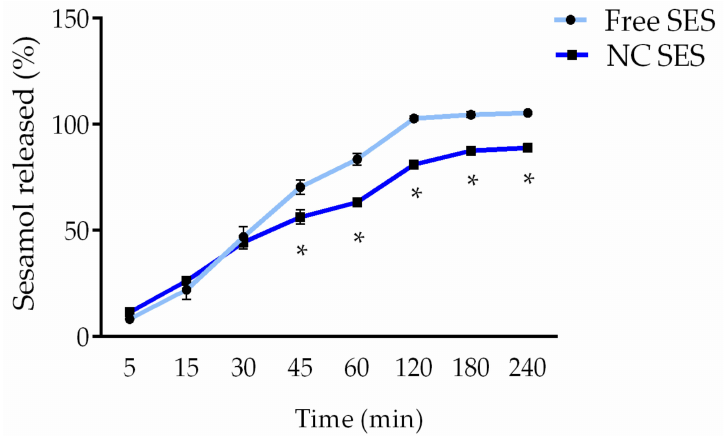
Figure 2. In vitro release profile of sesamol in the free (Free SES: light-blue line) or nanoencapsulated forms (NC SES: blue line). The values are reported as the mean ± SD of three independent experi- ments/group. All data were analyzed using the unpaired Student’s t -test at each point (individual time). The asterisks (*) denote a significant difference between the NC SES and Free SES (* p < 0.05).